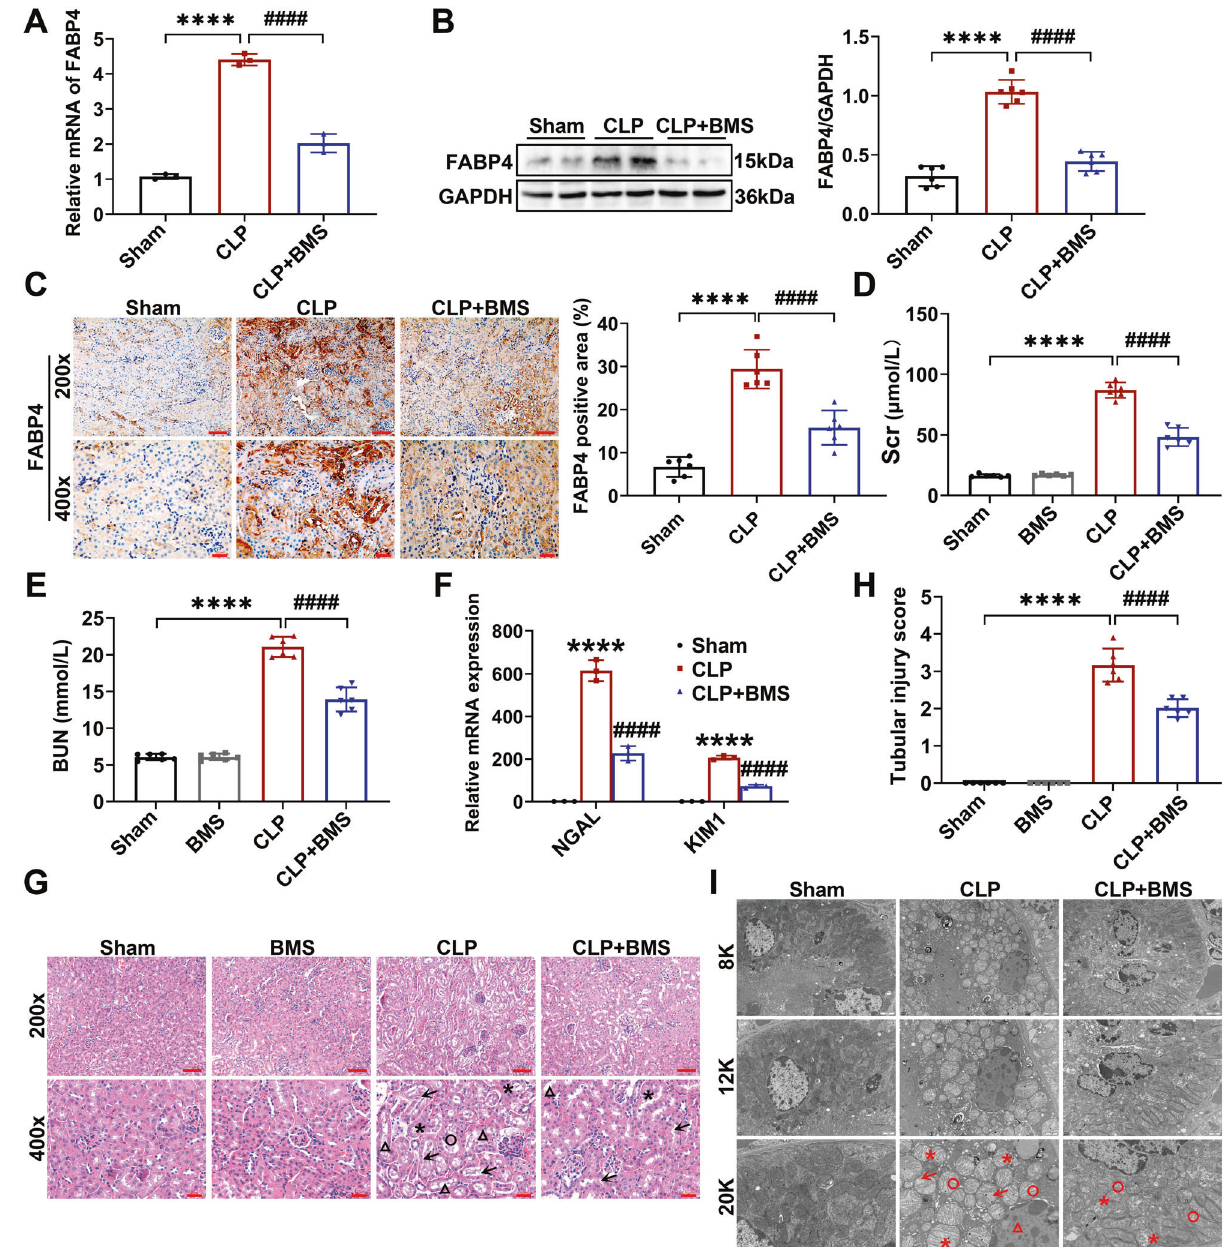
Fig. 2 FABP4 inhibitor BMS309403 treatment alleviated CLP-induced septic AKI in mice. C57BL/6J and BMS309403 (BMS)-treated C57BL/6J mice (male, 8 – 10 weeks old) were subjected to CLP or sham surgery and killed 16 h later. A The mRNA expression of FABP4 in the kidneys analyzed by quantitative real-time PCR analysis ( n = 3). B Protein expression of kidney FABP4 detected by western blotting and quanti fi ed by densitometry ( n = 6). C Representative micrographs and quantitative analysis of immunochemistry staining of FABP4 in kidney tissue sections (×200, scale bar = 50 μ m; ×400, scale bar = 20 μ m). D Serum creatinine (Scr) and ( E ) BUN concentrations in different groups of mice ( n = 6). F The mRNA expression of NGAL and KIM1 analyzed by quantitative real-time PCR analysis in kidney tissues ( n = 3). G Representative images of HE staining (×200, scale bar = 50 μ m; ×400, scale bar = 20 μ m) and H tubular injury scores of kidney tissues ( n = 6). Triangle: tubular dilatation; Asterisk: tubular swelling; Circle: cast formation; Arrow: loss of brush border. I Representative electron micrographs of renal tubular epithelial cells (RTECs) from different groups of mice (×8000, scale bar = 2 μ m; ×12,000, scale bar = 1 μ m; ×20,000, scale bar = 1 μ m). Triangle: chromosome condensation; Asterisk: mitochondrial swelling; Circle: mitochondrial cristate fused; Arrow: mitochondrial cristate disappeared. Data are shown as mean ± SD; **** P < 0.0001, versus Sham; #### P < 0.0001, versus CLP.